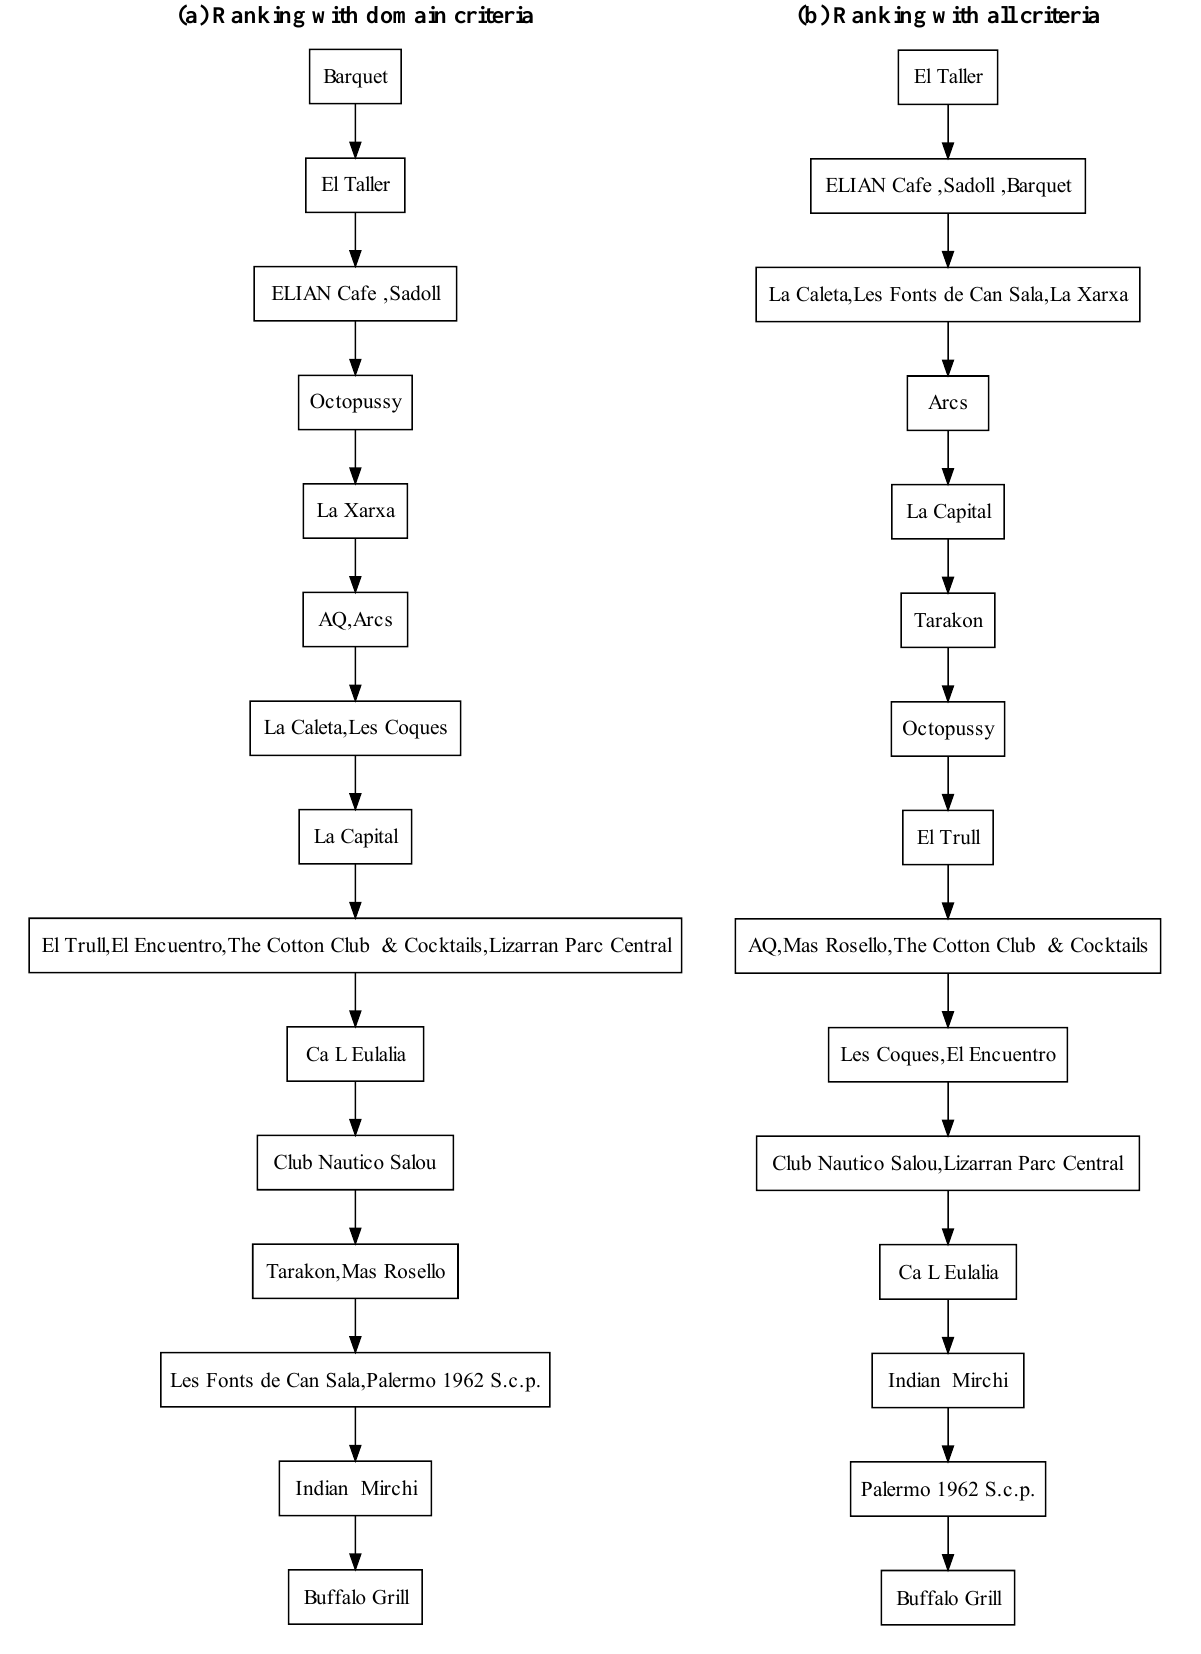
Figure 9. Profile 1: ranking